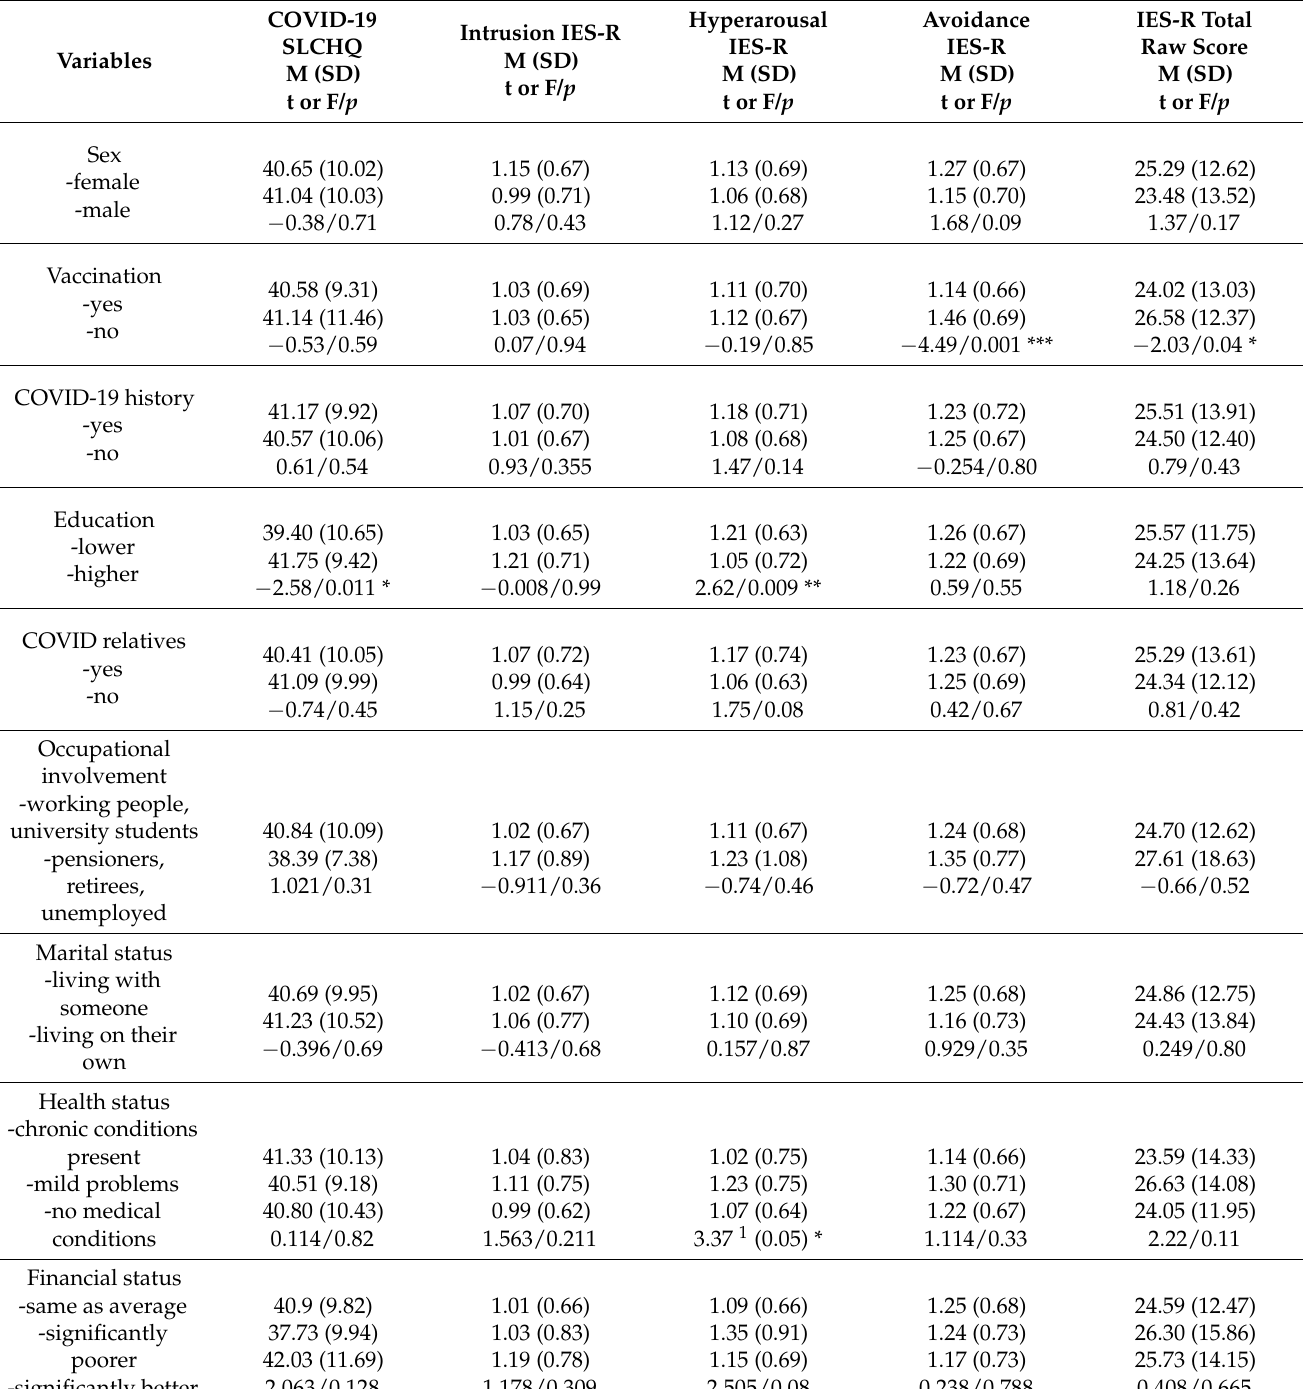
Table A1. The Impact of Event Scale: Revised (IES-R), and Sense of Life Changes Questionnaire (COVID-19 SLCHQ) scores—the comparisons with regard to different